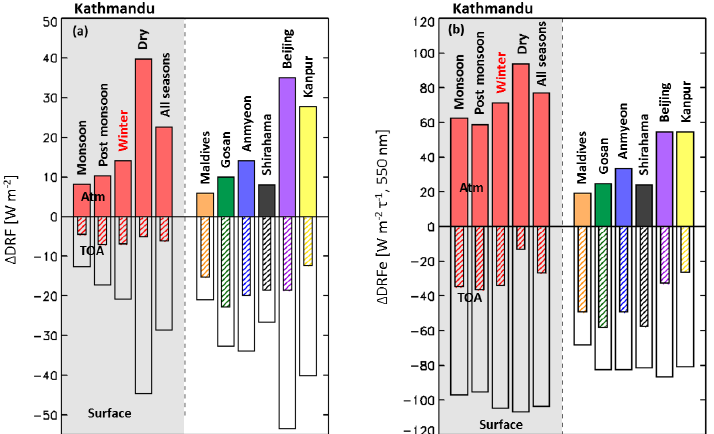
Figure 11. Comparison of the (a) aerosol radiative forcing and (b) aerosol radiative forcing efficiency in the Kathmandu Valley with that of other locations in Asia. The data period is the same as that given in Fig.